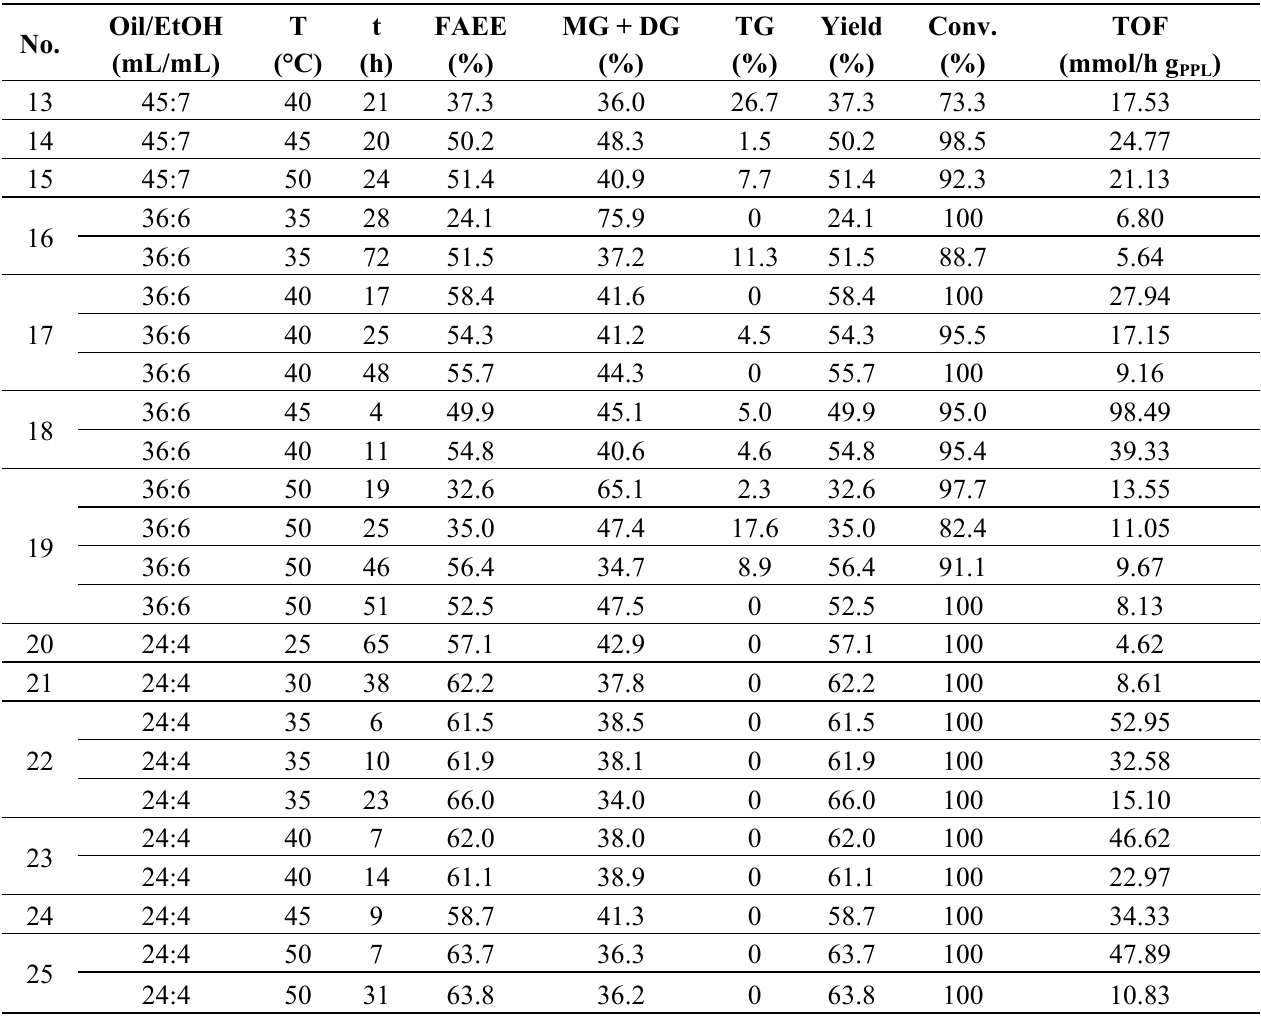
Table 2. Composition, yield, conversion and TOF of the biodiesel obtained in the transesterification reaction of waste cooking oil using 96% ethanol with the same biocatalyst used in Table 1: 0.038 g of immobilized PPL in 0.5 g of support with different ratios of oil/96% ethanol working in standard condition pH = 12, and different reaction time and